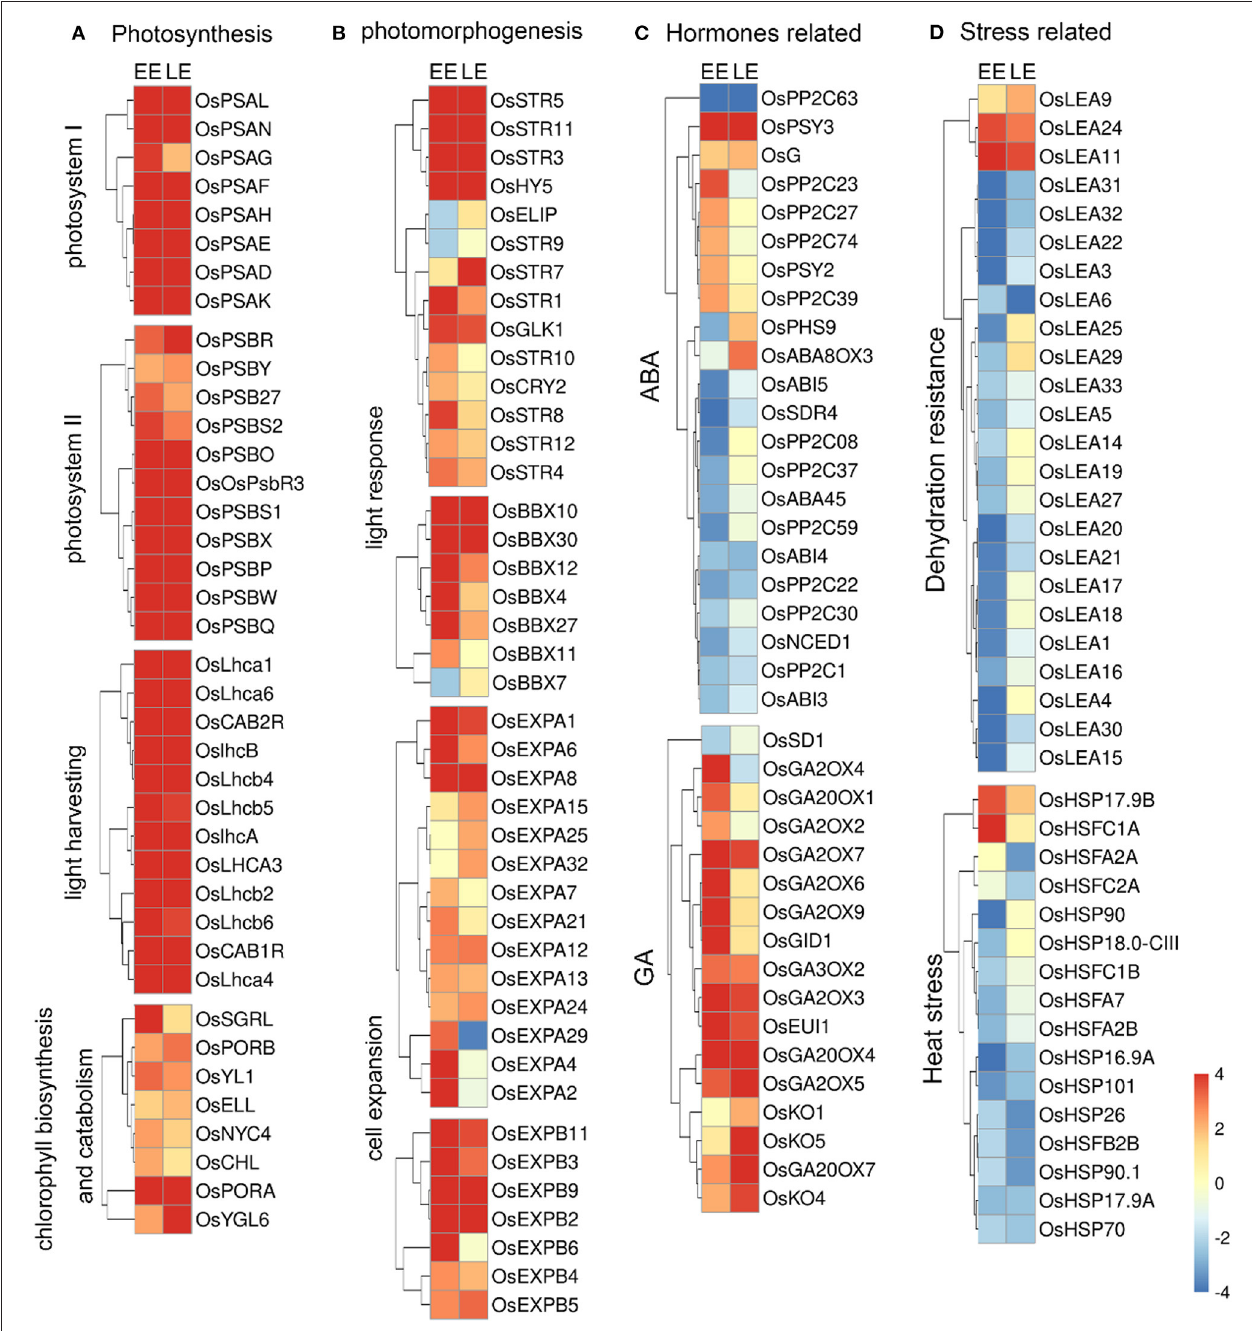
promoter ( Figure 6A ). The top enriched KEGG pathways ( p < 0.05) for these peak targets include amino sugar and nucleotide sugar metabolism (ko00520), butanoate